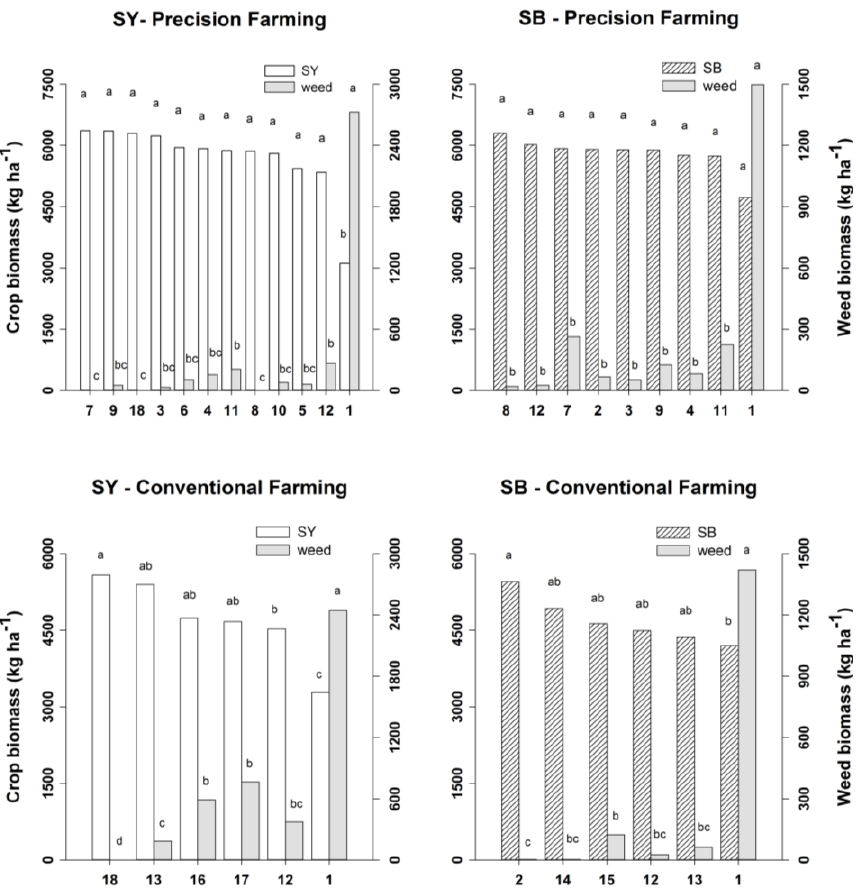
Figure 2. Shoot dry biomass of weeds and soybean (SY), shoot and root dry biomass of sugar beet (SB) measured eight weeks after sowing; weeds were controlled using